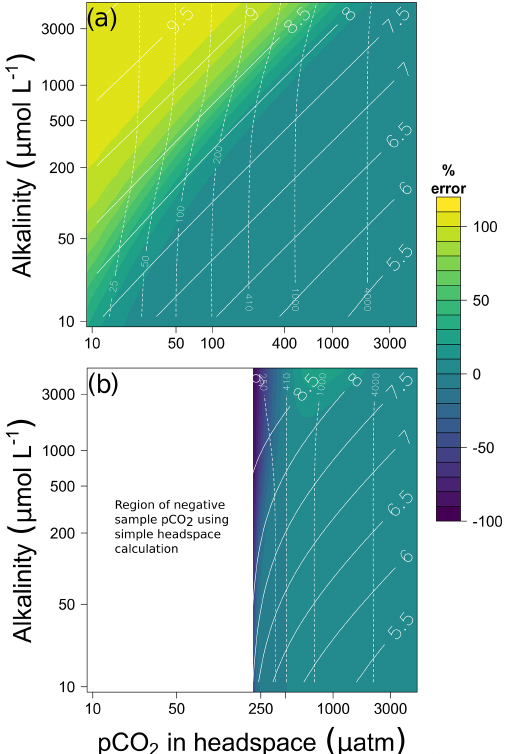
Figure 1. Error (%) when applying simple headspace calculations of p CO 2 on hypothetical water samples of different alkalinity and p CO 2 in the headspace after equilibration for (a) CO 2 -free gas headspace and (b) ambient-air headspace assuming a pressure of 1atm. The resulting pH and p CO 2 of the samples are depicted as full and dashed lines, respectively. The headspace ratio is 1:1, and the equilibration and field temperature is 20 ◦ C. Note the log scale in all axes. In panel (b) results for p CO 2 in headspace after equili- bration lower than 215µatm are masked, because they would imply negative p CO 2 in the